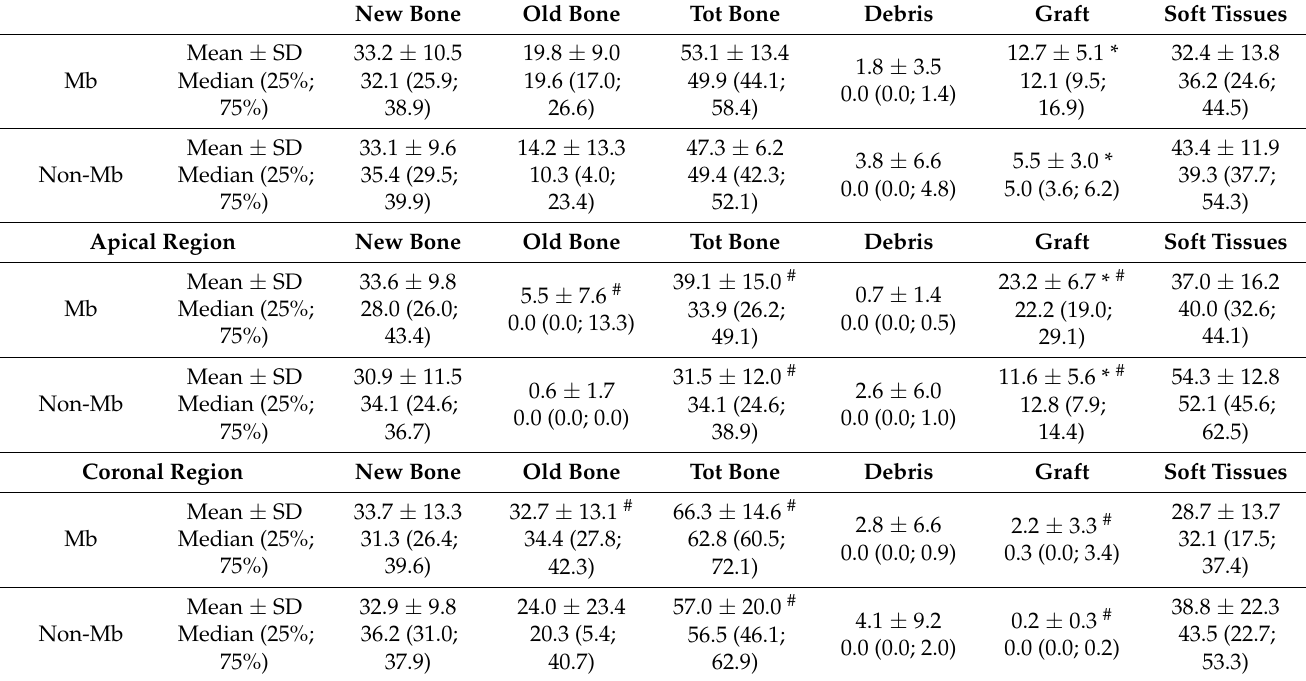
Table 3. Membrane group (Mb, n = 8) and non-membrane group (non-Mb, n = 7). Tissue density around the implant surface expressed in percentages (%) for the whole implant surface and for the apical and coronal regions of the implant. SD, standard deviation; 25%, first percentile; 75%, third percentile; * = p < 0.05 between Mb and non-Mb groups; # = p < 0.05 between apical and coronal regions. New Bone Old Bone Tot Bone Debris Graft Soft Tissues